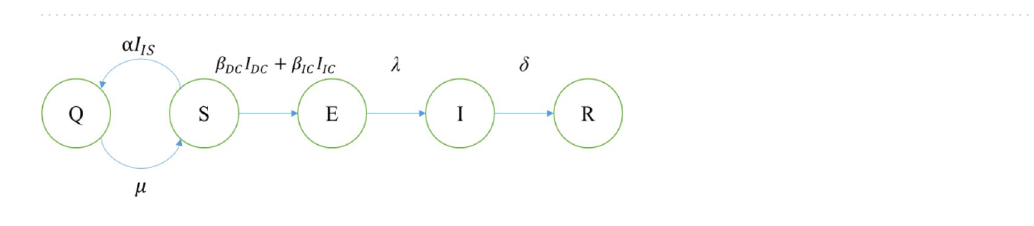
Figure 4. SQEIR model transition